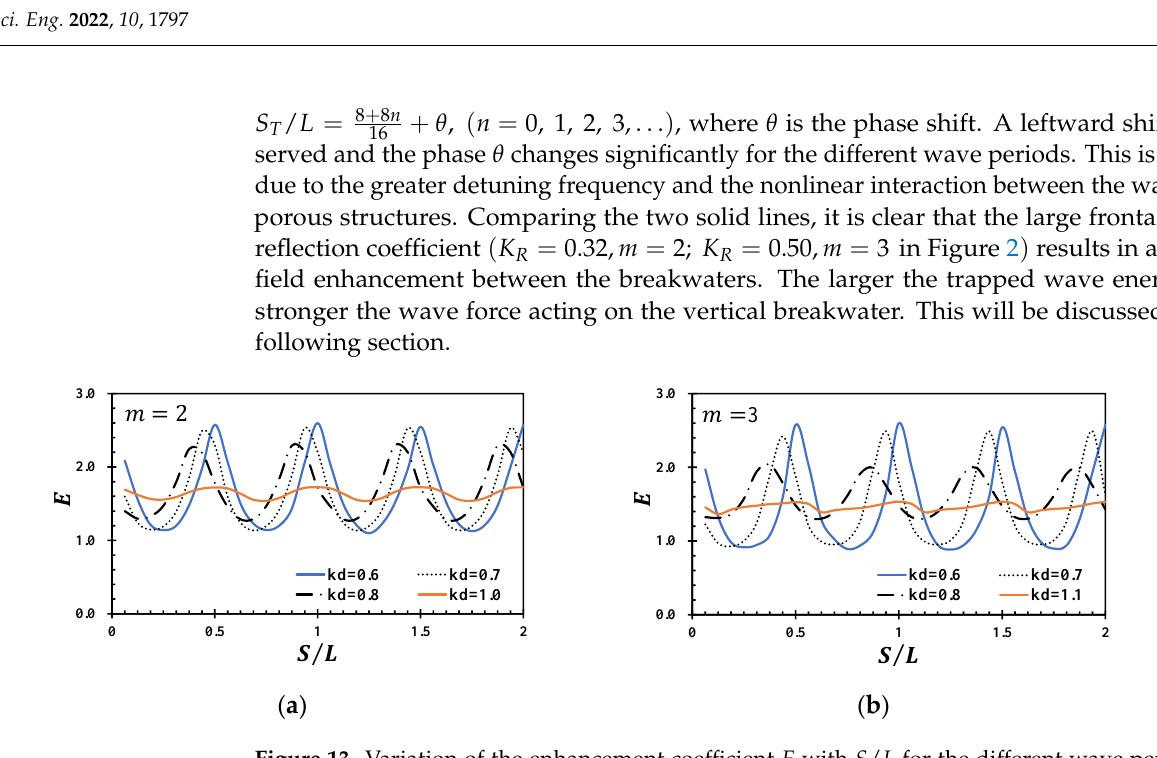
( b ) Figure 12. Variation of 𝐾 𝑅 and 𝐾 𝐷 for the different porosities of the submerged breakwaters (𝑚 = 3) with 𝑘𝑑 = 0.6 , ( a ) reflection coefficient 𝐾 𝑅 . ( b ) dissipation coefficient 𝐾 𝐷 . Based on the above discussions, it can be concluded that the distance between the submerged breakwaters and the vertical breakwater has a significant influence on the wave transformation. This may further affect the shelter of the submerged breakwaters, which is part of the focus of this study and will be discussed in the following sections. 4.3. Enhancement Coefficient Based on the above discussion, we can find the analogy between the water wave trapping mechanism and the F – P resonance in the optics. Without the consideration of the dissipation in the optics, the resonator length of the F – P resonance can be easily deter- mined by the coefficient of the reflection or the transmission. For a given resonator length, the partial wave is reflected back, the trapped wave by the breakwaters constructively interferes and the F – P resonance condition is satisfied. In this study, the enhancement coefficient is defined by the amplitude of the water wave within the resonator in [16]: